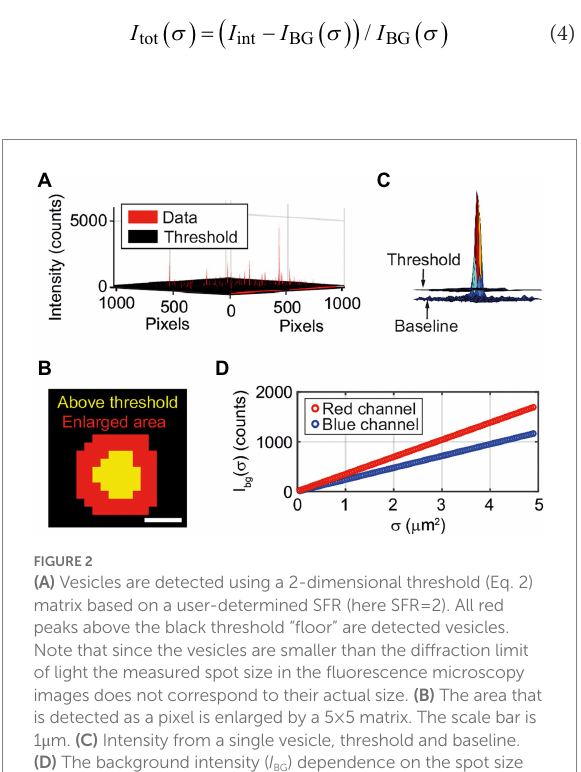
FIGURE 2 (A) Vesicles are detected using a 2-dimensional threshold (Eq. 2) matrix based on a user-determined SFR (here SFR = 2). All red peaks above the black threshold “floor” are detected vesicles. Note that since the vesicles are smaller than the diffraction limit of light the measured spot size in the fluorescence microscopy images does not correspond to their actual size. (B) The area that is detected as a pixel is enlarged by a 5 × 5 matrix. The scale bar is